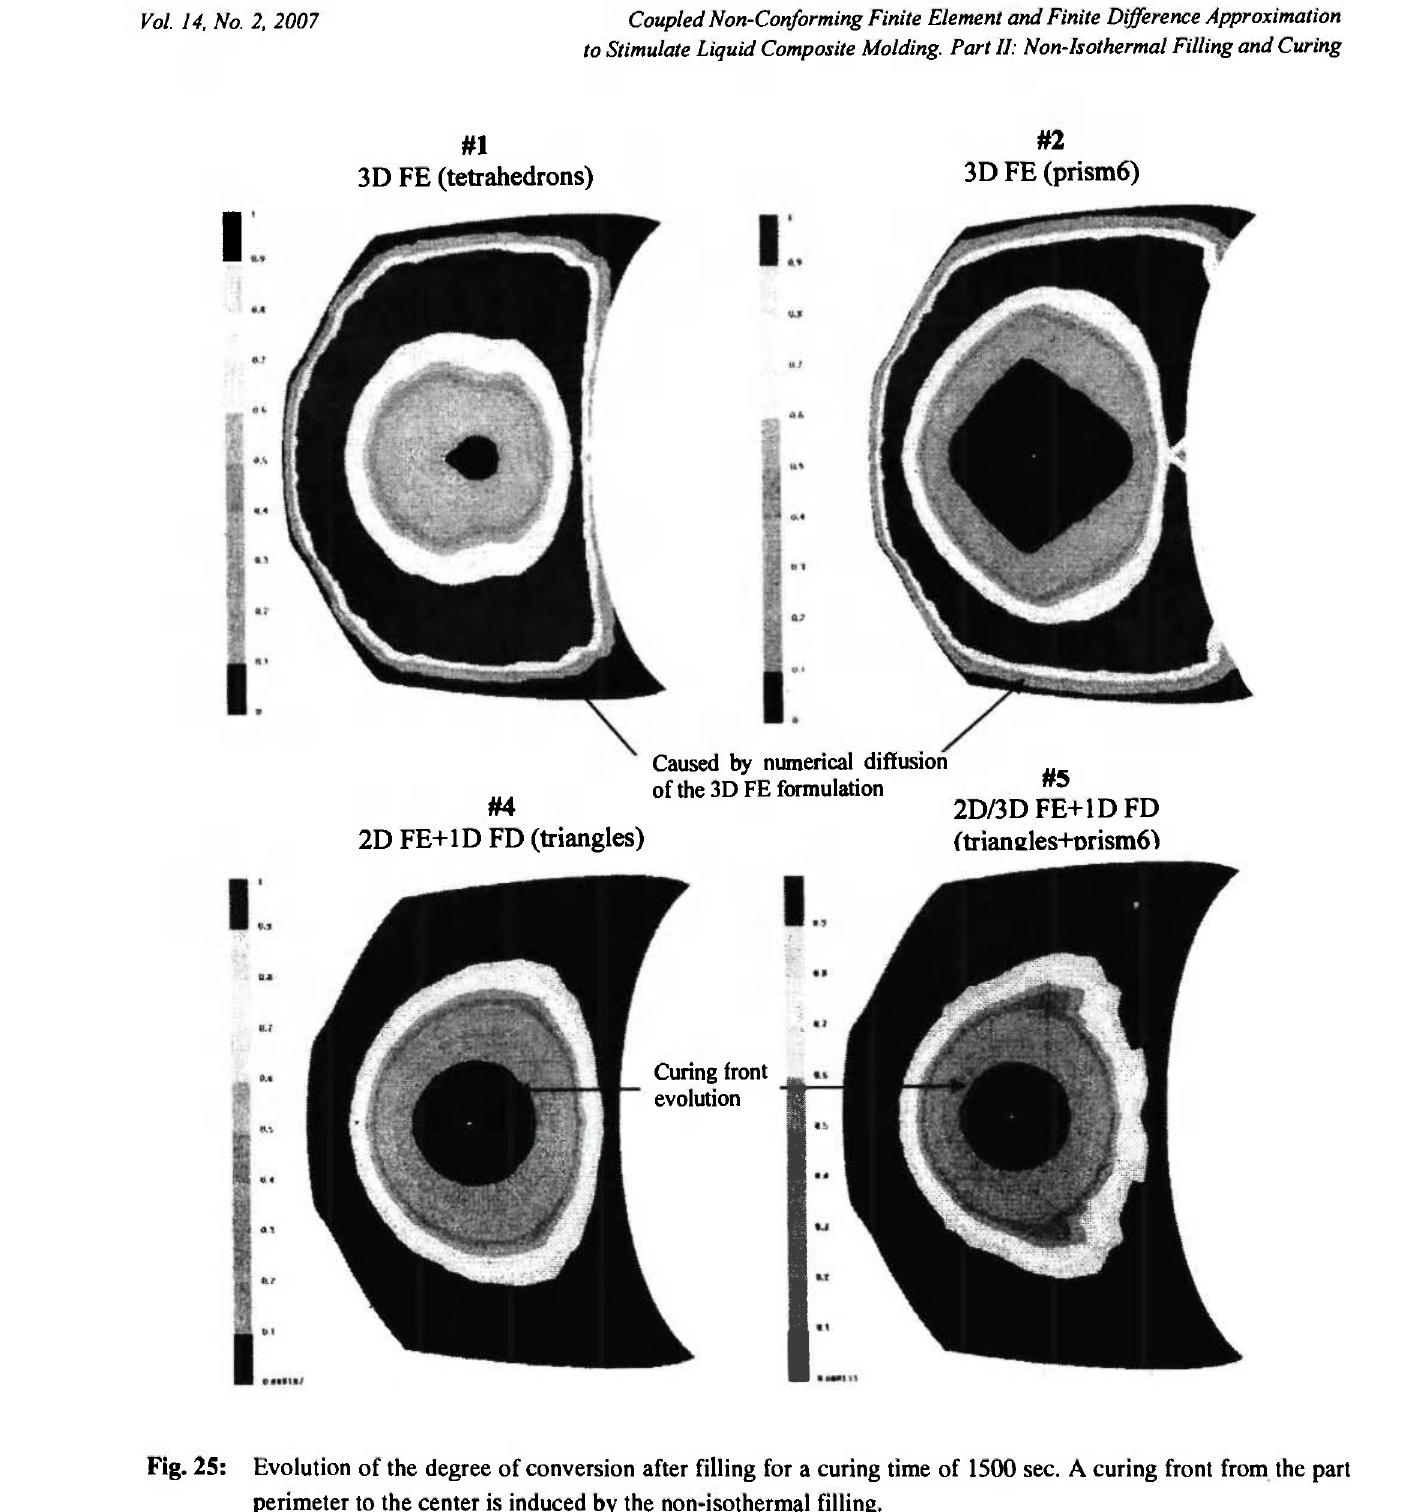
Fig. 25: Evolution of the degree of conversion after filling for a curing time of 1500 sec. A curing front from the part perimeter to the center is induced by the non-isothermal